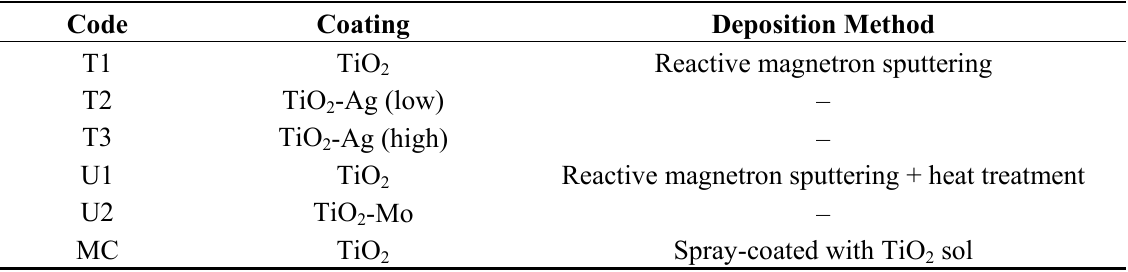
Table 1. Preparation method of coated